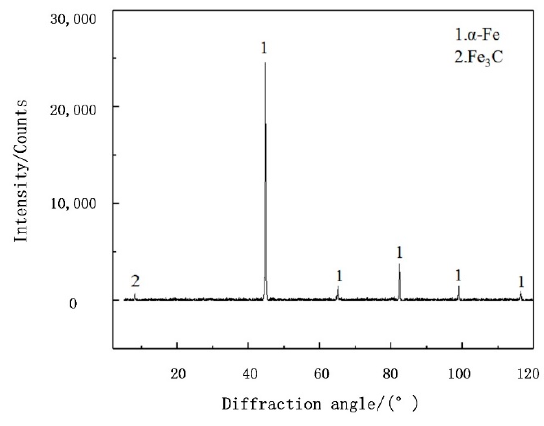
Figure 11. XRD pattern of Grade A marine steel.